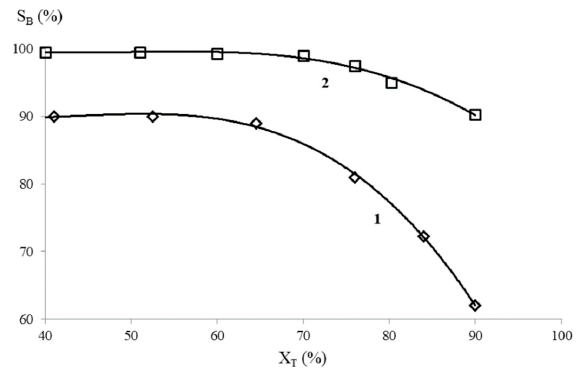
Figure 5. Toluene conversion to benzene under temperature 753 K, pressure 0.75 MPa and WHSV =